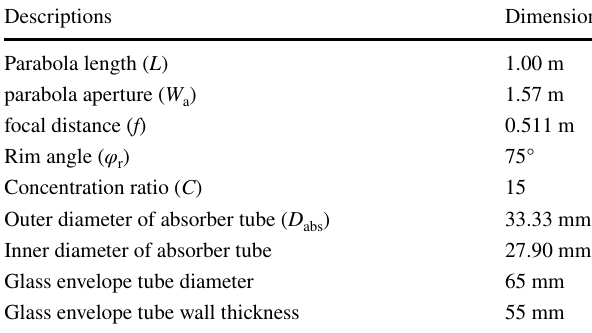
Table 1 Dimensions of the parabolic trough and solar receiver tube for the PTC